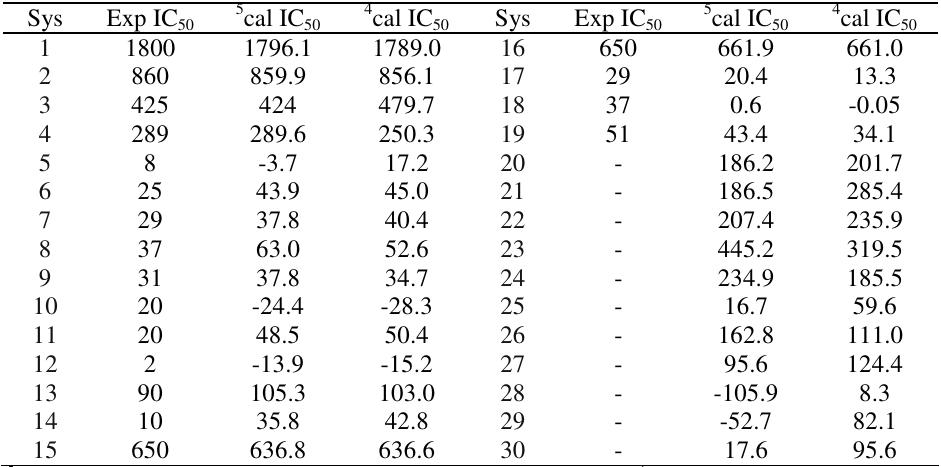
Table 4. Experimental IC scheme 1 using QSAR models in eqs. 4 and 5